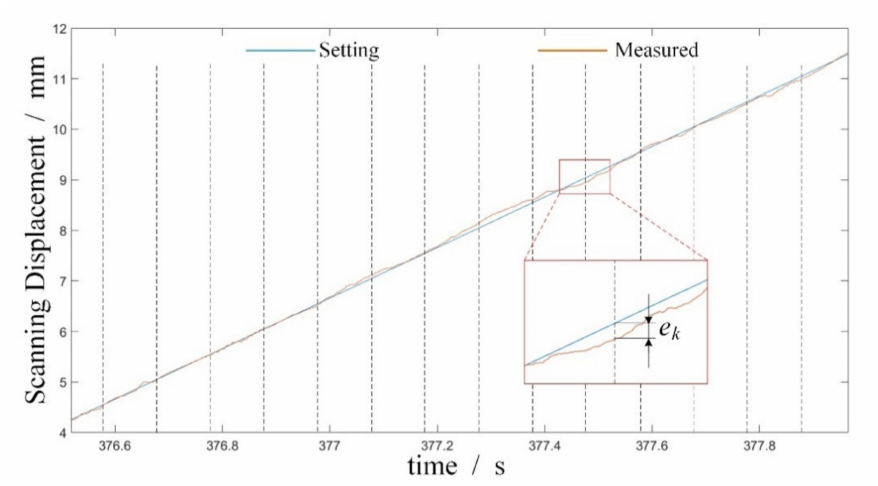
Figure 11. Laser scanning